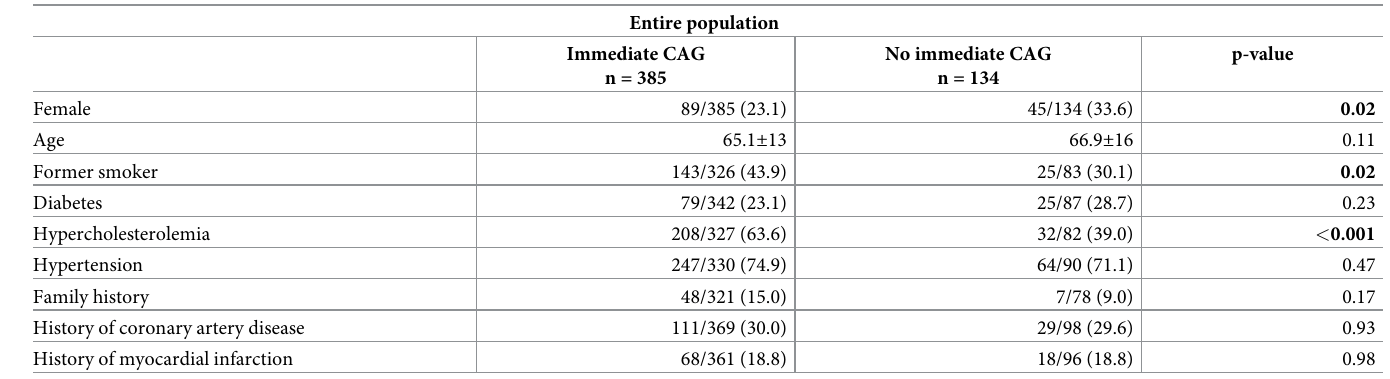
Data are presented as n (%) of the total cohort.